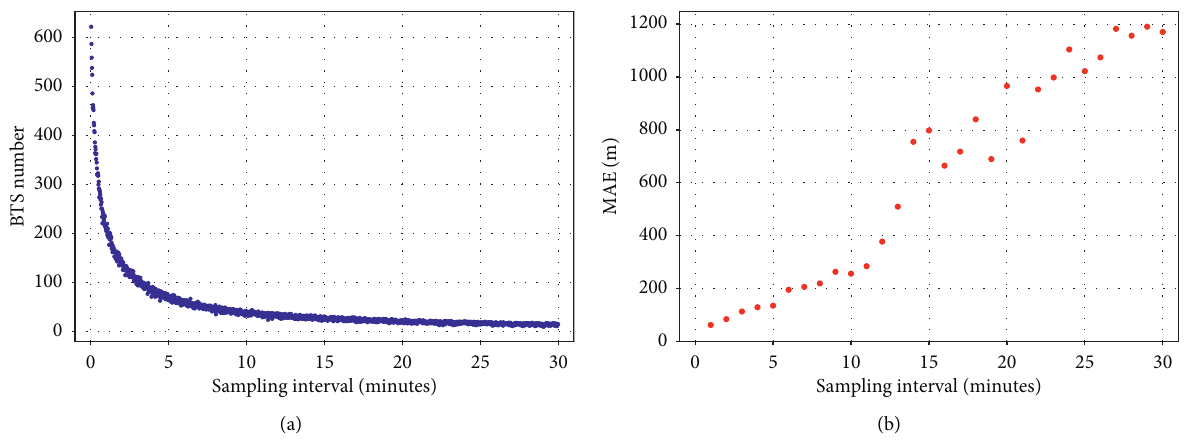
Figure 12: Cell-id trajectories with different sampling intervals. (a) BTS numbers. (b) Errors of estimated anchor